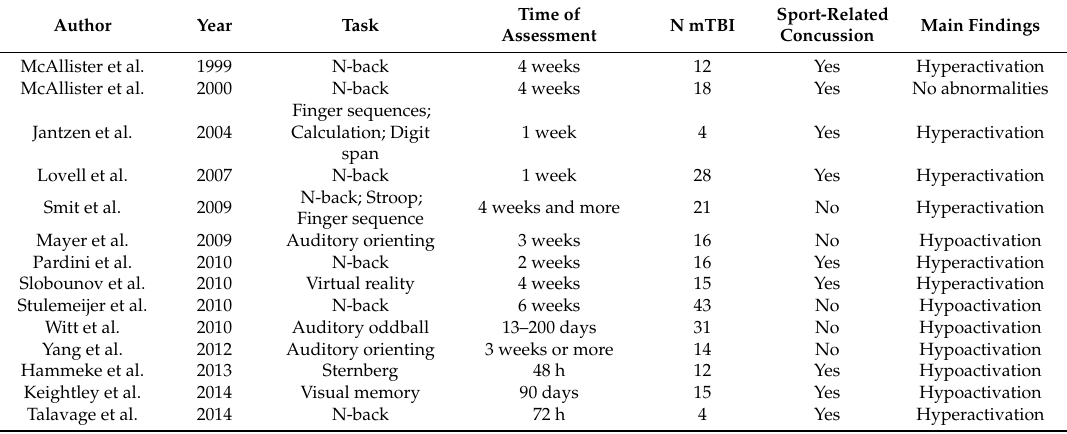
Table 3. Task-related functional Magnetic Resonance Imaging (fMRI) within 4 weeks from